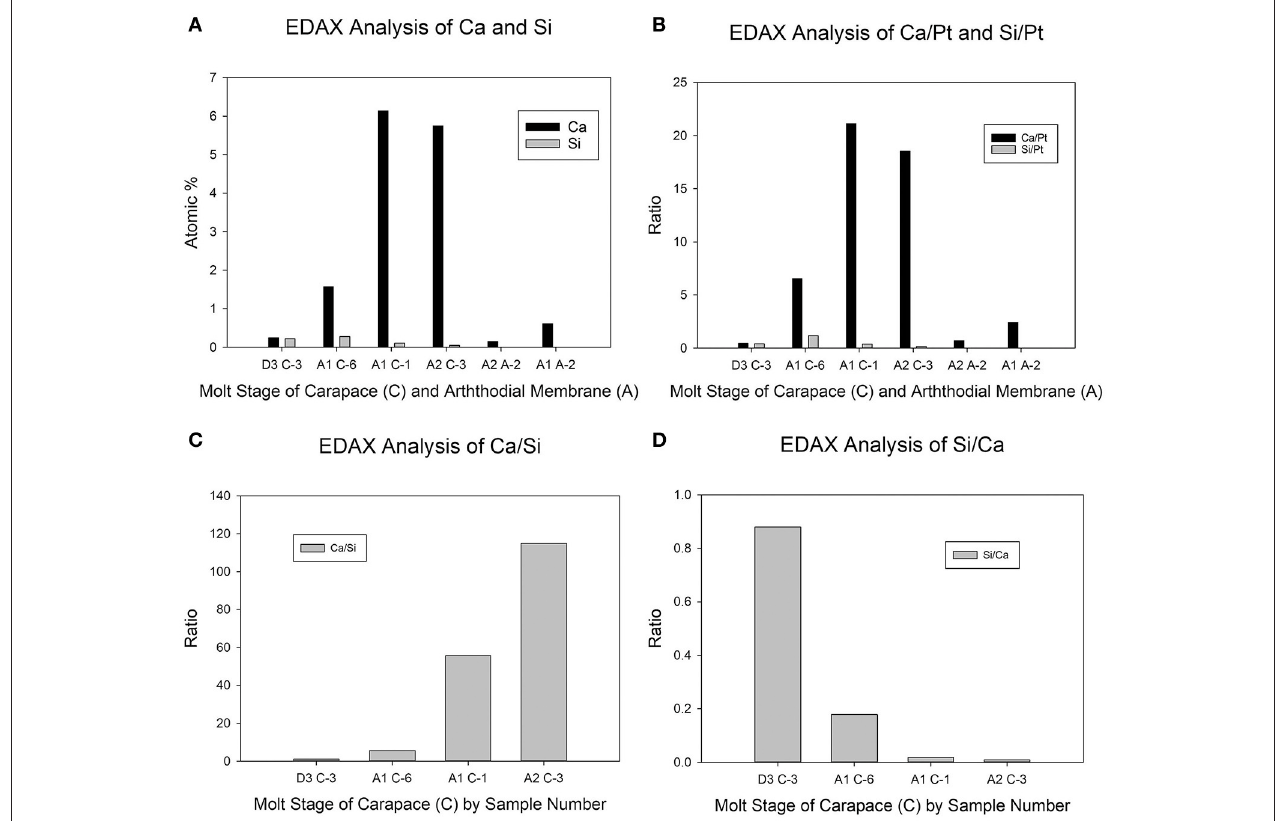
FIGURE 2 | Semiquantitative elemental analysis of EDAX maps. The x-axis legends represent the molt stage (D3, A1, or A2) followed by the tissue type (C = carapace; A = arthrodial membrane) followed by the sample number (1–6 for a given tissue type and molt stage). (A) Atomic percent of Ca and Si. (B) The same data as in 2A, but represented as the ratio of the Ca or Si atomic percent with that of Pt. (C) The data for the carapace samples in 2A represented as the Ca:Si ratio. (D) The same data as in 2C, but represented as the Si:Ca ratio. Neither of the semiquantitative analyses in panels (A,B) showed significant levels of Si in arthrodial membrane, hence these samples were excluded from the ratios (C,D)